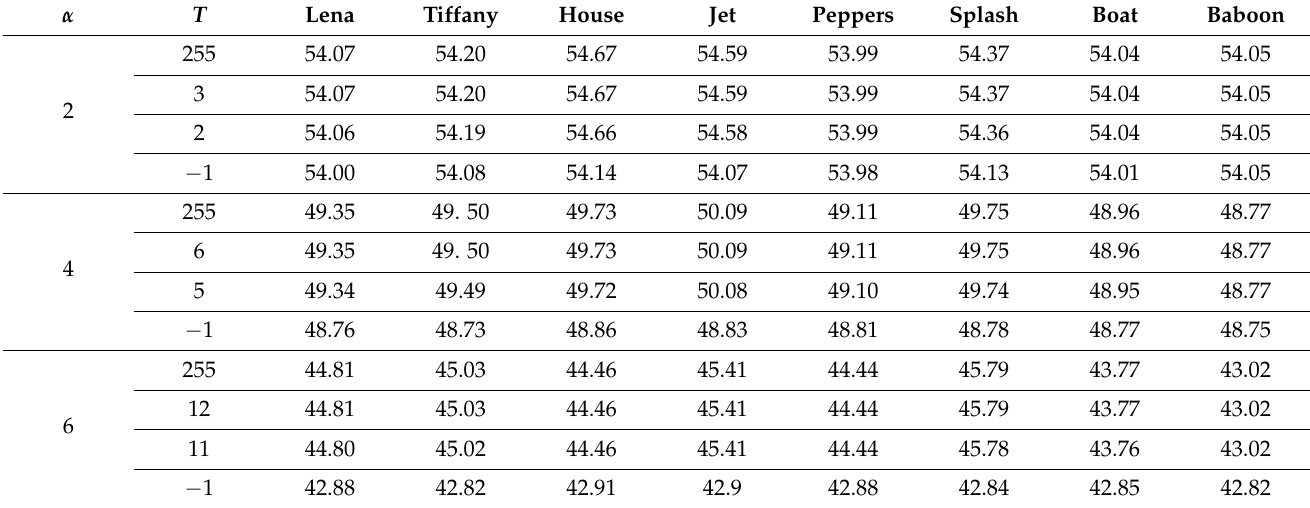
Table 1. Comparisons of image quality for different thresholds when α = 2, 4, 6.